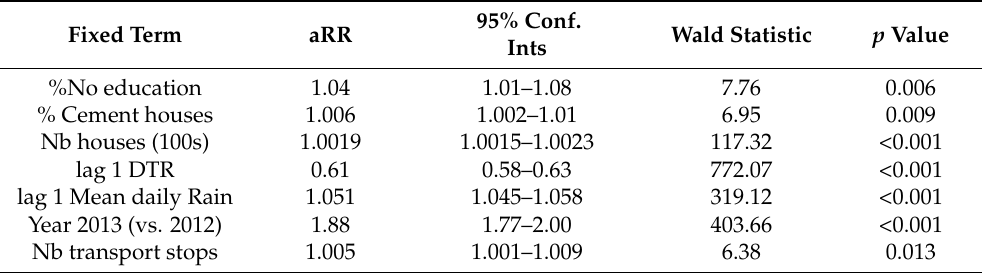
Table 3. Association of socio-economic variables, meteorological factors, and year with dengue cases in the final adequate multivariable